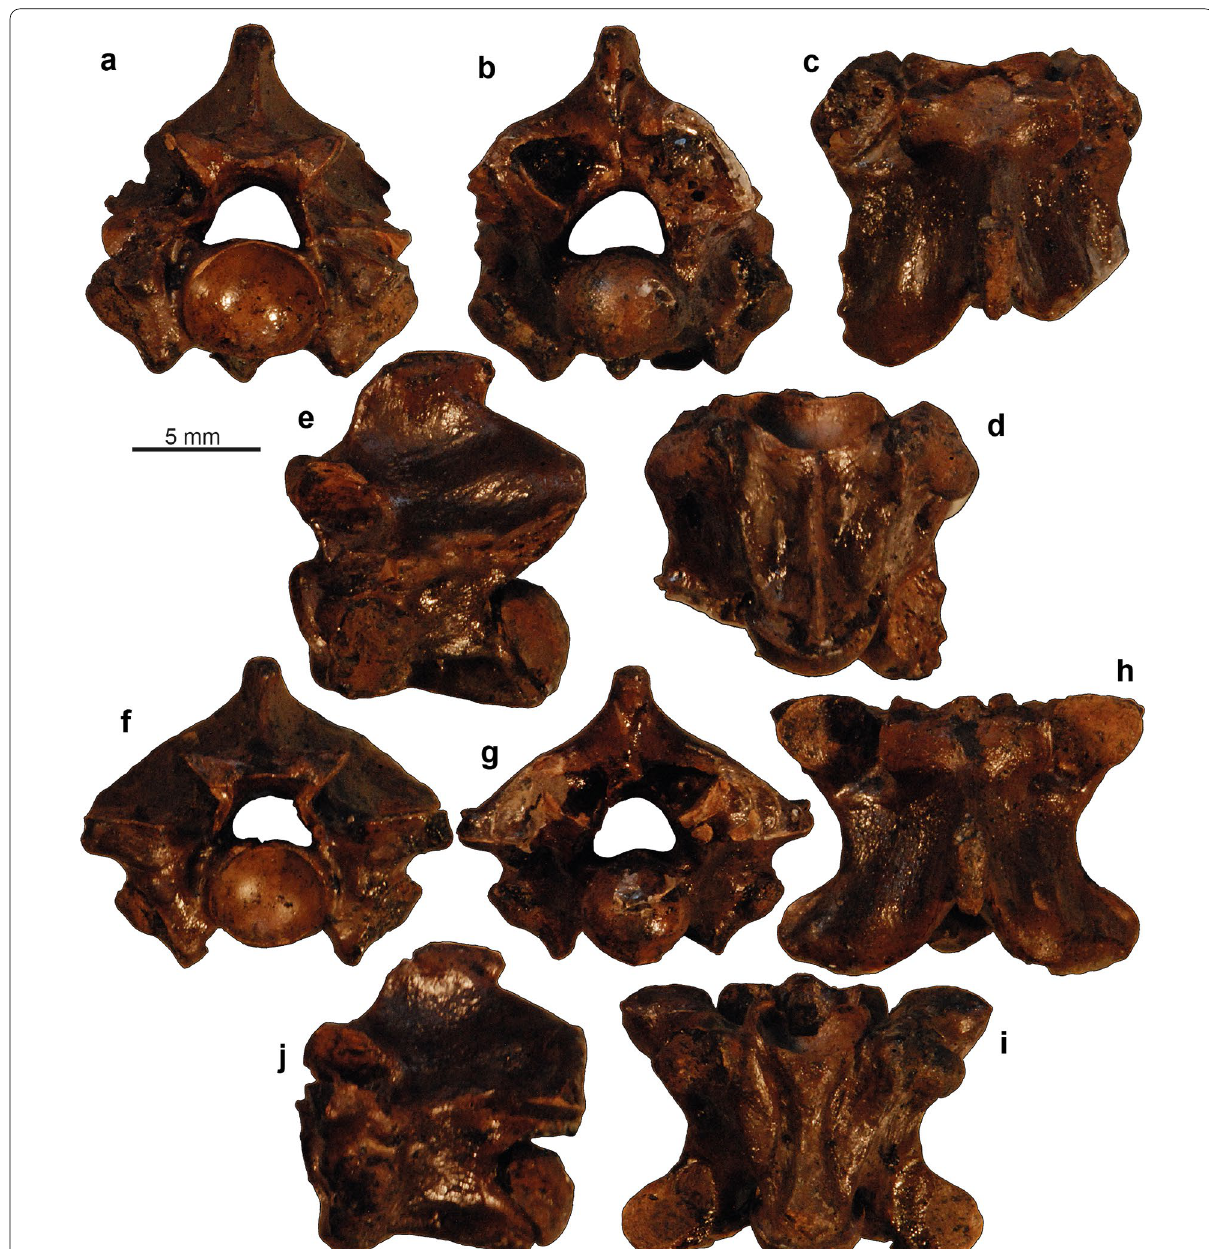
Fig. 56 Eoconstrictor cf. fischeri from quarry VI, Geiseltal: a – e mid-trunk vertebra (GMH VIa-529a-1952) in anterior ( a ), posterior ( b ), dorsal ( c ), ventral ( d ), and left lateral ( e ) views; f – h posterior trunk vertebra (GMH VIa-529b-1952) in anterior ( f ), posterior ( g ), dorsal ( h ), ventral ( i ), and left lateral ( j )